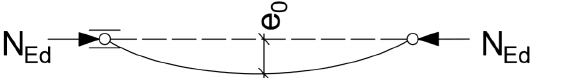
Figure 4. Initial geometrical imperfection. The structural imperfections were included in the numerical analysis in the form of residual stresses. The commonly used distribution of residual stresses for hot rolled I and